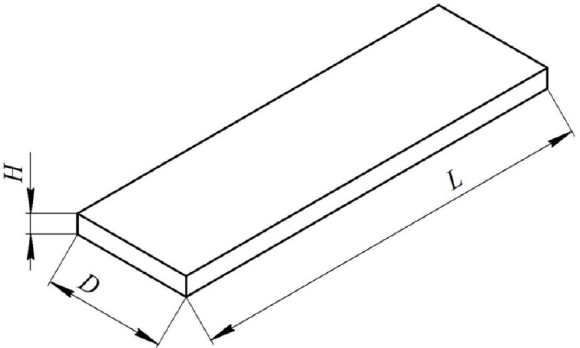
Figure 2. Geometric dimensions of design areas.